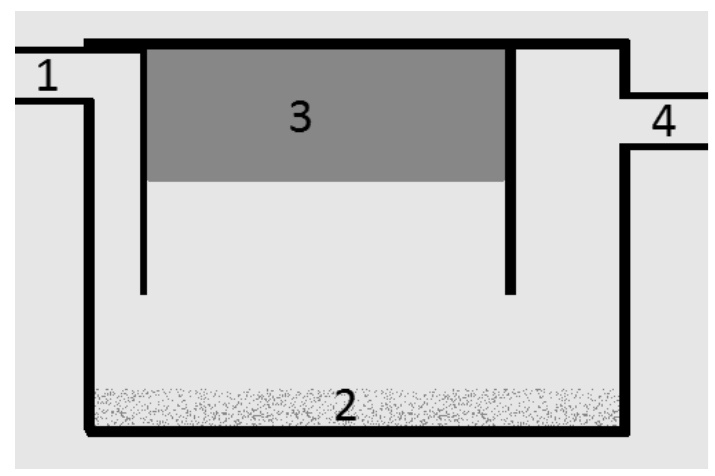
Figure 2. The grease box composition: 1, wastewater entrance; 2, solid residues; 3, fats; and 4, exit to sewage.